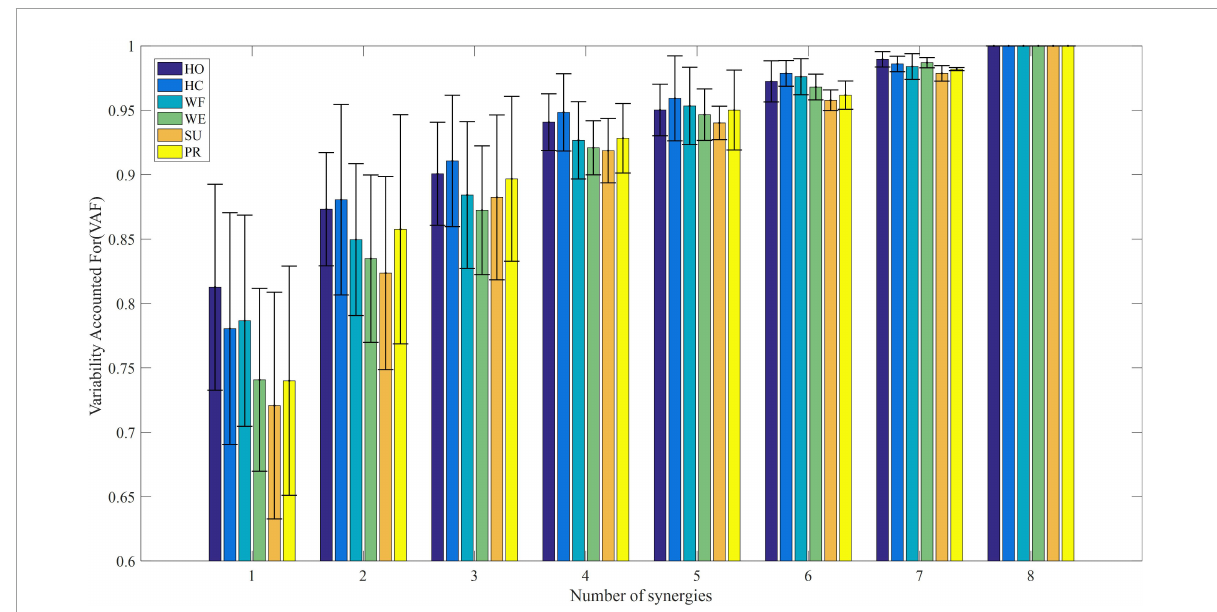
FIGURE3 The relationship between average variability accounted for (VAF) and module amount under different upper limb